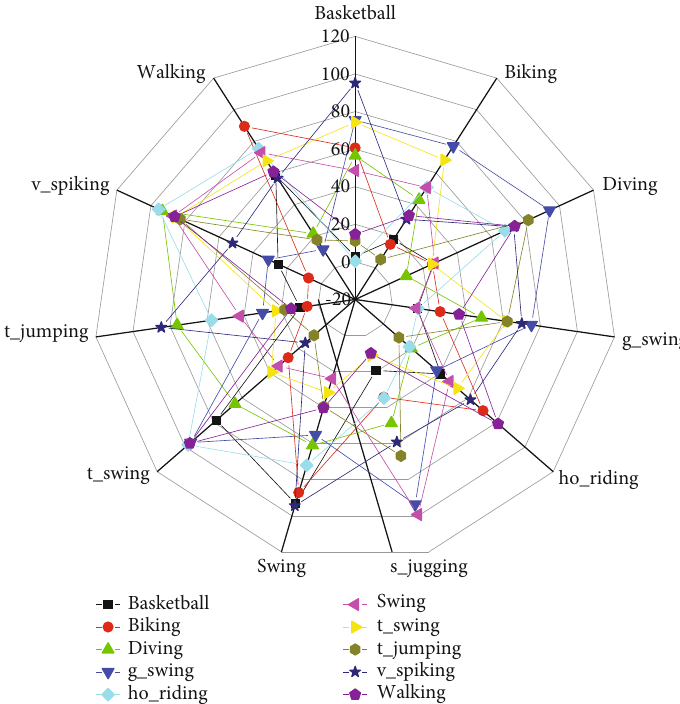
Figure 8: Action recognition interaction time